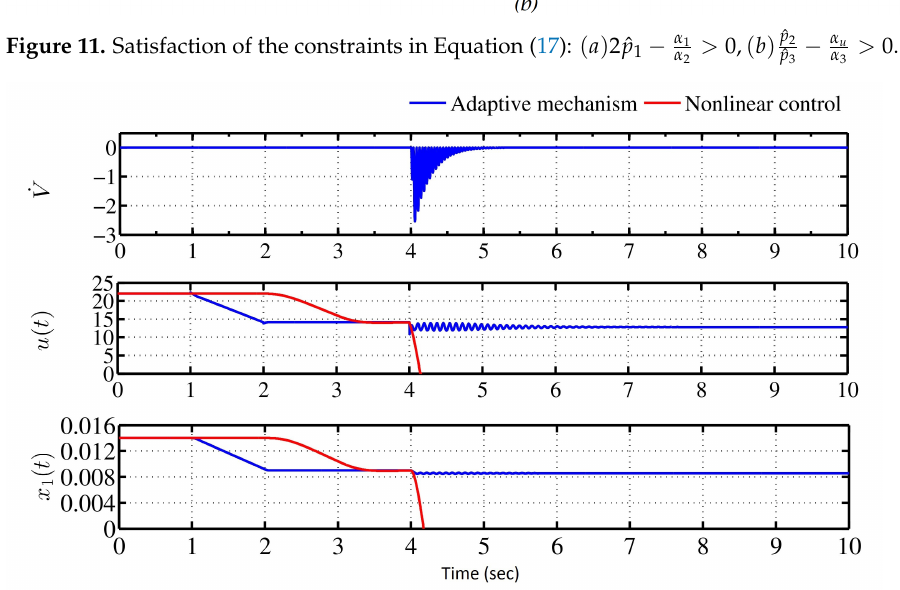
Figure 11. Satisfaction of the constraints in Equation (17): ( a ) 2 ˆ p 1 − α 1